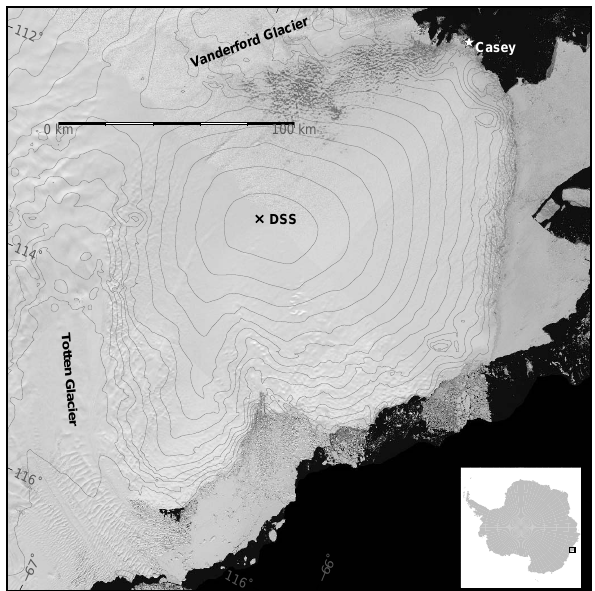
Figure 1. Location of the drilling site for the 1196m Dome Summit South (DSS) ice core on Law Dome, East Antarctica. The drill site is 4.7km SSW from the dome summit. The background image is from the Landsat Image Mosaic of Antarctica (Bindschadler et al., 2008) and 100m elevation contours from Bamber et al.